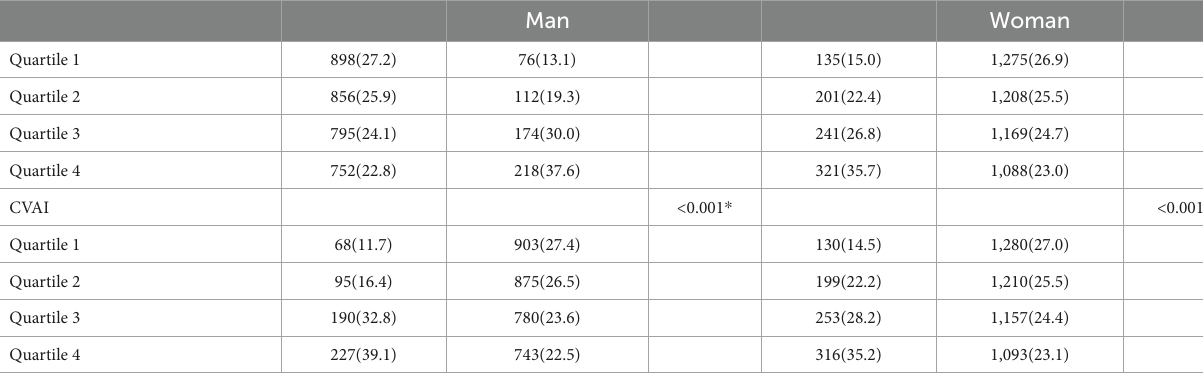
Figure 1 is based on the ROC curve to analyze the diagnostic ability of anthropometric Indices (including BMI, WC, NC, WHR, LAP, VAI, and CVAI) for DM in men and women. BMI, WC, NC, WHR, LAP, VAI, and CVAI were statistically different between males and females ( p < 0.01). In Figure 1A, the areas under ROC curve of BMI, WC, NC, WHR, WHtR, VAI and CVAI of male DM were 0.590, 0.644, 0.620, 0.653, 0.634, 0.616 and 0.655 (all p < 0.001). Compared under the ROC curve, the critical value of the maximum Youden